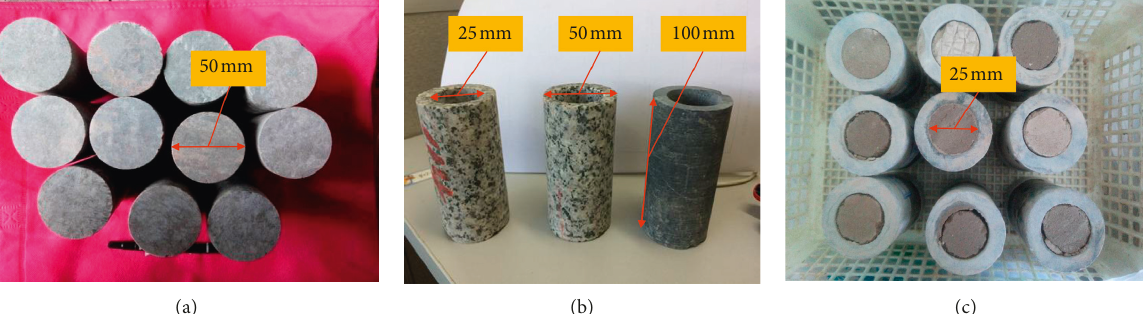
Figure 2: Preparation of RCTMC samples at laboratory: (a) rock specimens; (b) thick-walled hollow cylinder specimens; and (c) RCTMC samples.